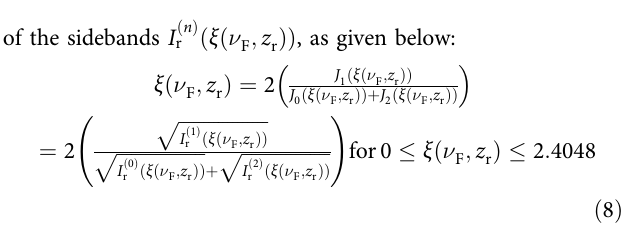
Fig. 5 Data processing steps to obtain the local response of forward stimulated Brillouin scattering. a The measured intensity I ð n Þ r ð z 1st, and 2nd order spectral sidebands versus distance z r , obtained at the FSBS peak resonant frequency ν res . b Phase factor ξ ( z r ) retrieved by using the Bessel recurrence relation in Eq. 8. c The local amplitude of refractive index changes a RI ( z ) (unitless) that is obtained by using